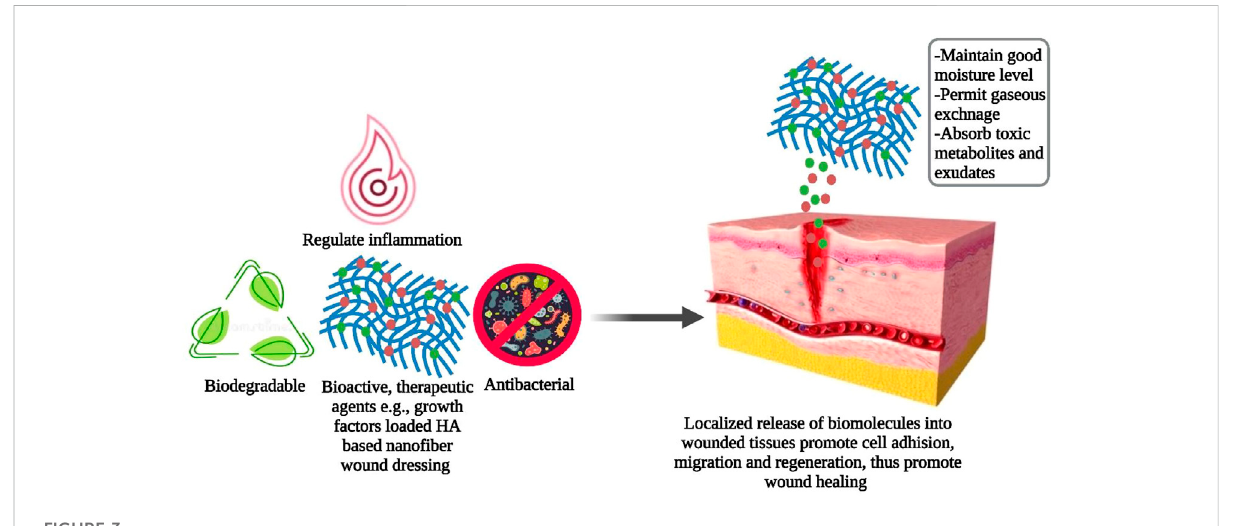
FIGURE 3 Mechanism adopted by HA-based wound dressings for wound